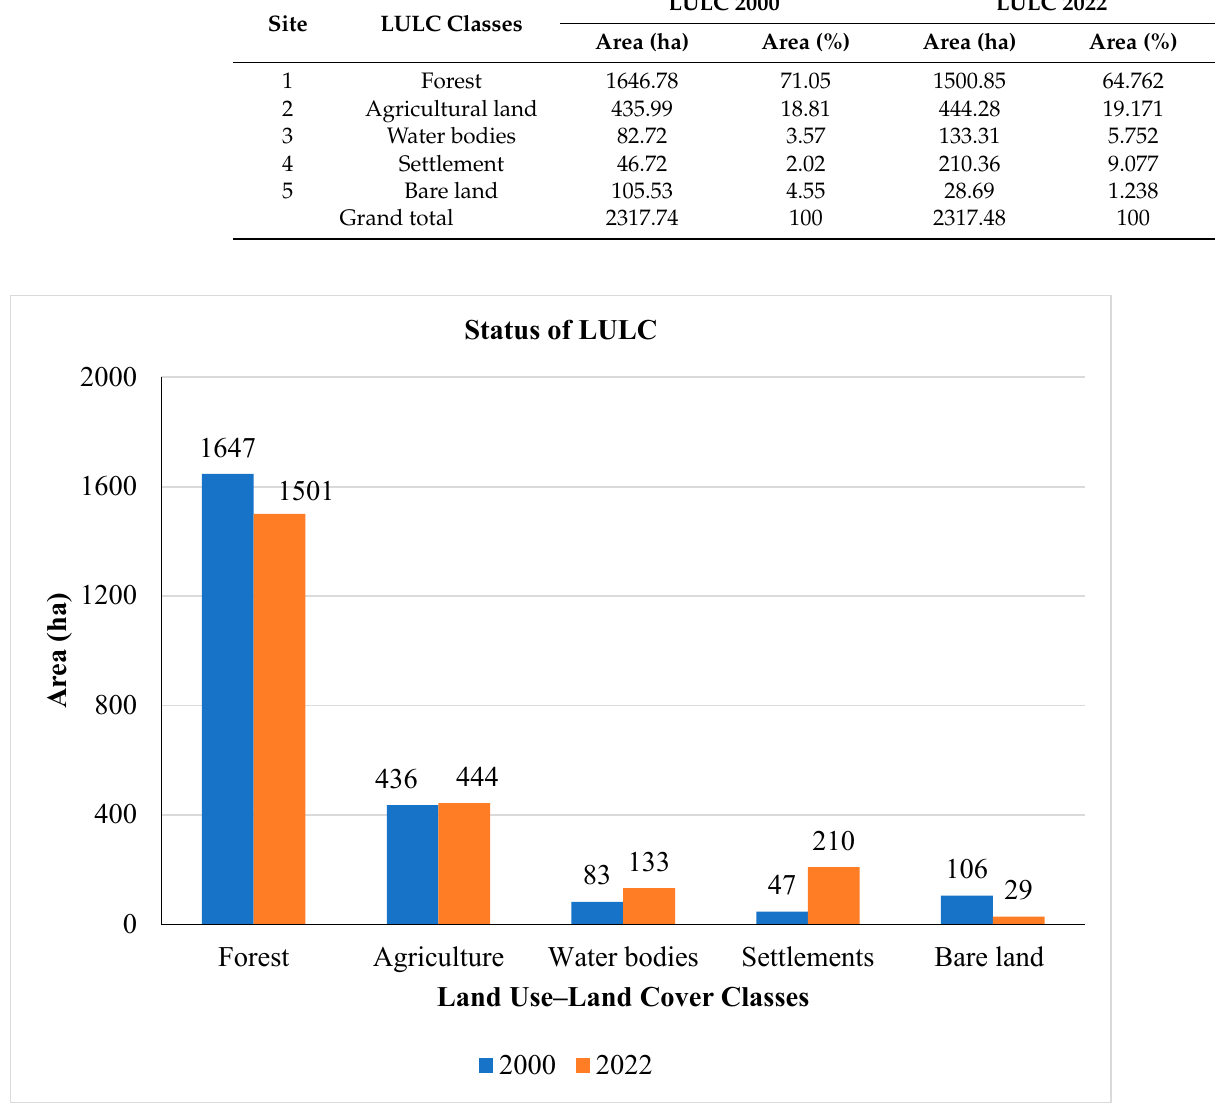
Figure 3. Histogram of land use and land cover (LULC) change in Ghodaghodi Lake Complex (GLC), Nepal, 2000 (April) and 2022 (April).